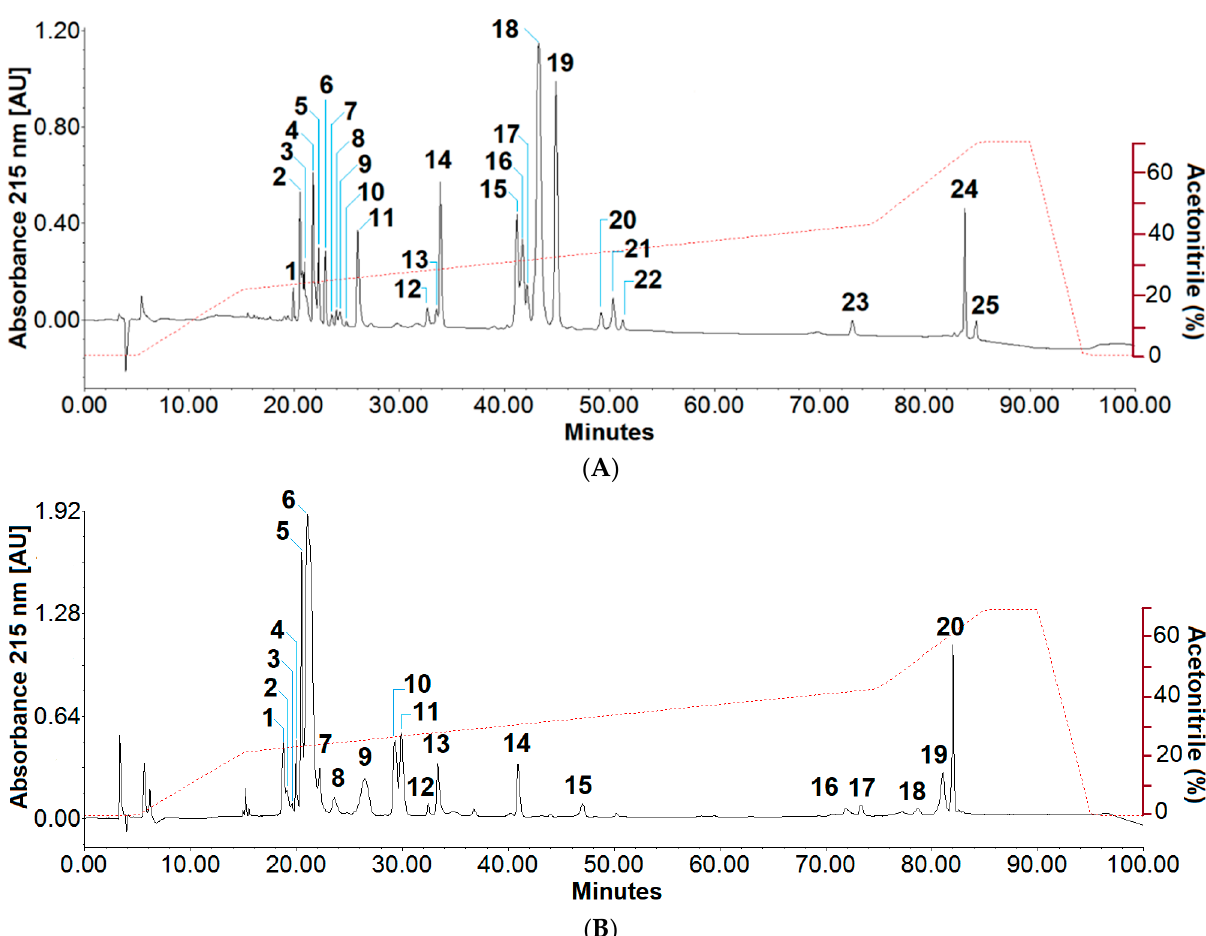
Figure 3. Fractionation of the Ecuadorian coral venoms of ( A ) M. helleri and ( B ) M. mipartitus by RP-HPLC. The peaks were identified according to their elution through a C18 column for further characterisation by electrophoresis and mass spectrometry analyses. The separation of venom toxins was performed in the gradient (red-dashed lines) elution mode described in the methodology